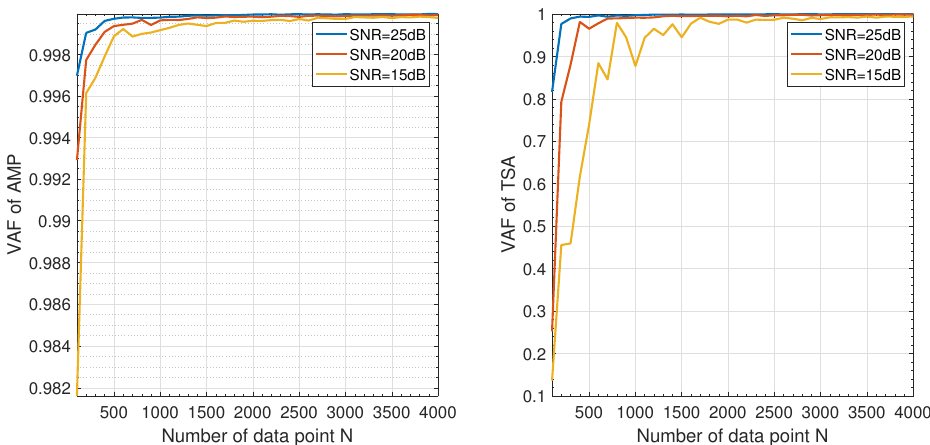
Figure 5. Averaged results of VAF for APM ( left , red line) and TSA ( right , blue line) under different N and SNRs, where N ∈ [ 100,4000 ]